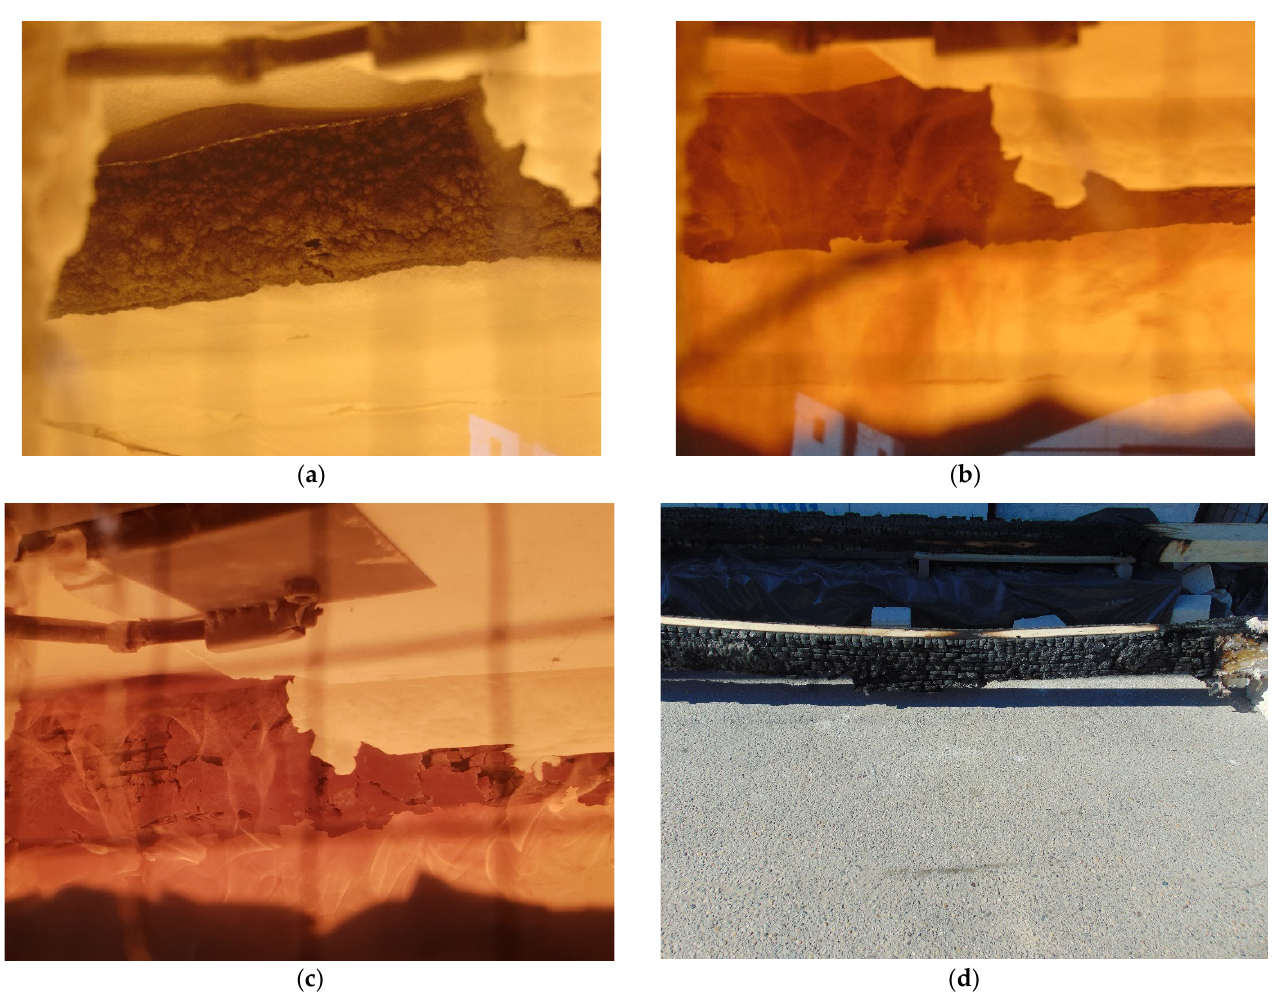
Figure 19. Hollow beam (Mineral wool)—phases of the fire test: ( a ) 5 min; ( b ) 20 min; ( c ) 41 min; ( d ) the end of the test.